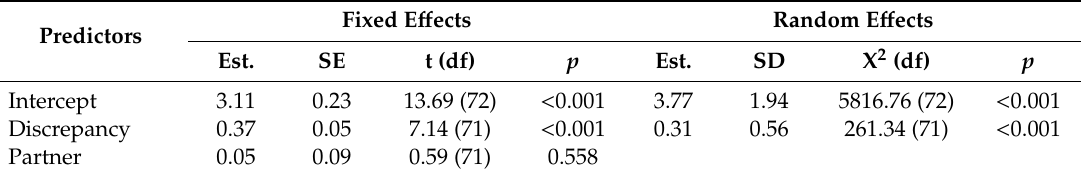
Table A3. Parameter estimates for multilevel model A.3.